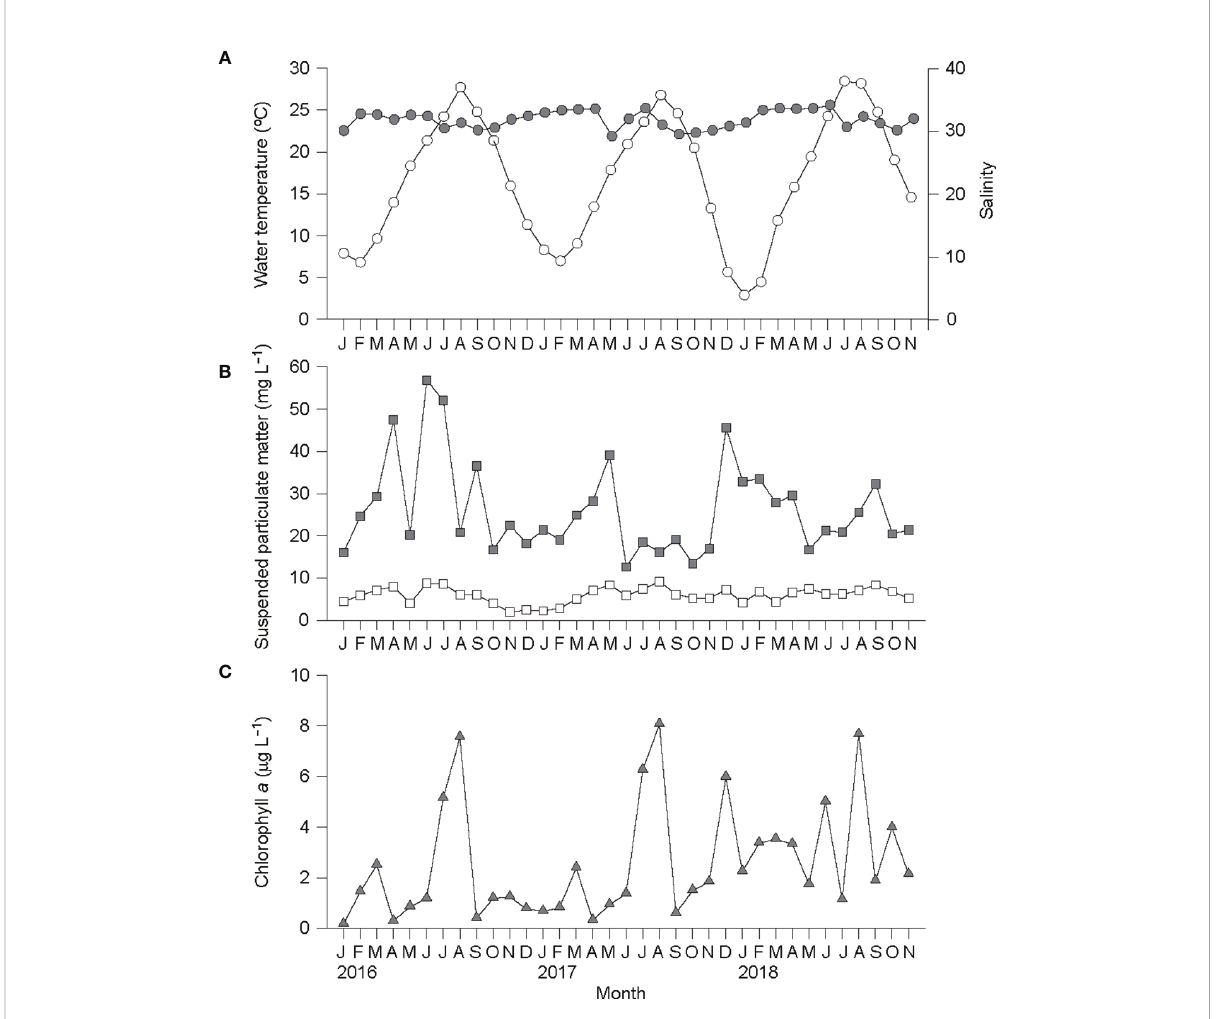
FIGURE 7 Seasonal variations in water temperature (open circle) and salinity (gray circle) (A) , total suspended particulate matter (gray square) and suspended particulate organic matter (open square) concentrations (B) , and chlorophyll a concentration (C) in a water column located at the ark shell culturing site in Yeoja Bay,